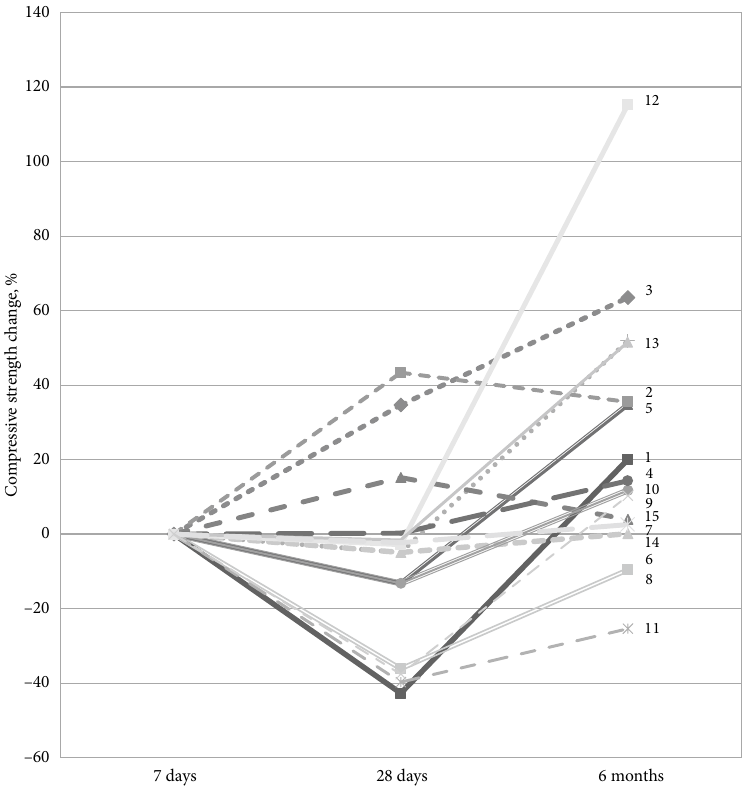
Figure 6. Relative change in strength after 28 days and 6 months in comparison with strength after 7 days: –1 – 100% C + 0% FA and 80% CP + 20% Sa; 2 – 100% C + 0% FA and 60% CP + 40% Sa; 3 – 100% C + 0% FA and 40% CP + 60% Sa; 4 – 90% C + 10% FA and 80% CP + 20% Sa; 5 – 90% C + 10% FA and 60% CP + 40% Sa; 6 – 90% C + 10% FA and 40% CP + 60% Sa; 7 – 80% C + 20% FA and 80% CP + 20% Sa; 8 – 80% C + 20% FA and 60% CP + 40% Sa; 9 – 80% C + 20% FA and 40% CP + 60% Sa; 10 – 70% C + 30% FA and 80% CP + 20% Sa; 11 – 70% C + 30% FA and 60% CP + 40% Sa; 12 – 70% C + 30% FA and 40% CP + 60% Sa; 13 – 60% C + 40% FA and 80% CP + 20% Sa; 14 – 60% C + 40% FA and 60% CP + 40% Sa; 15 – 60% C + 40% FA and 40% CP + 60% Sa